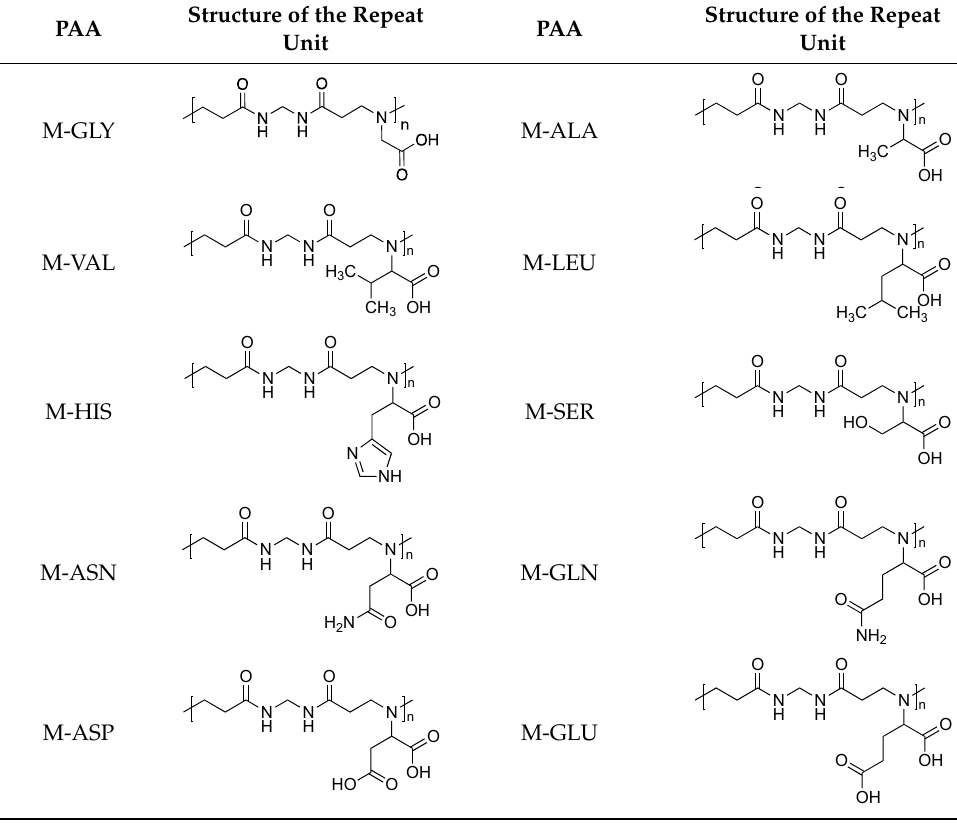
Scheme 1. Synthesis of PAAs. Table 2. Structure of the α -amino acid-derived PAA repeat units. Table 2. Structure of the α -amino acid-derived PAA repeat units. Table 2. Structure of the α -amino acid-derived PAA repeat units. Table 2. Structure of the α -amino acid-derived PAA repeat units. Table 2. Structure of the α -amino acid-derived PAA repeat units. Table 2. Structure of the α -amino acid-derived PAA repeat units. Table 2. Structure of the α -amino acid-derived PAA repeat units. Table 2. Structure of the α -amino acid-derived PAA repeat units. Table 2. Structure of the α -amino acid-derived PAA repeat units. Table 2. Structure of the α -amino acid-derived PAA repeat units. Table 2. Structure of the α -amino acid-derived PAA repeat units. PAA PAA Structure of the Repeat Unit PAA Structure of the Repeat Unit PAA